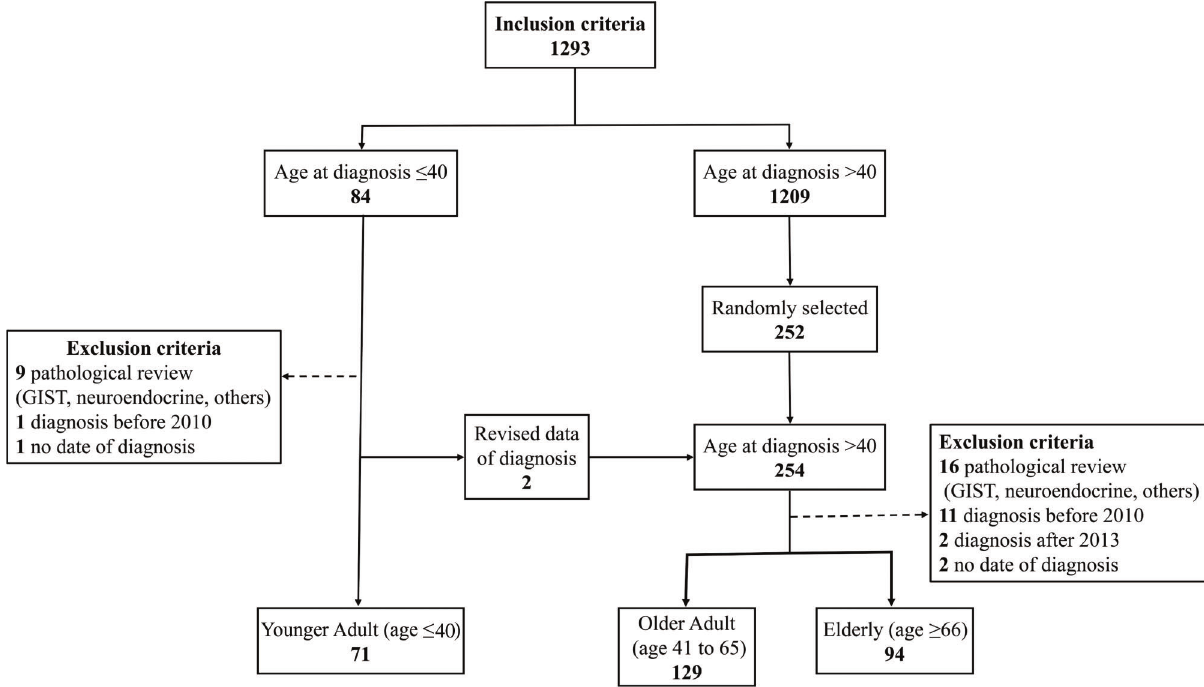
Figure 1 - Flowchart of patient